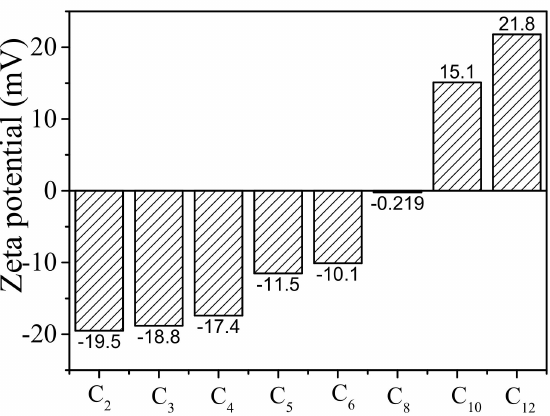
Figure A4. Zeta potential of ILs with different alkyl chains at high concentration.